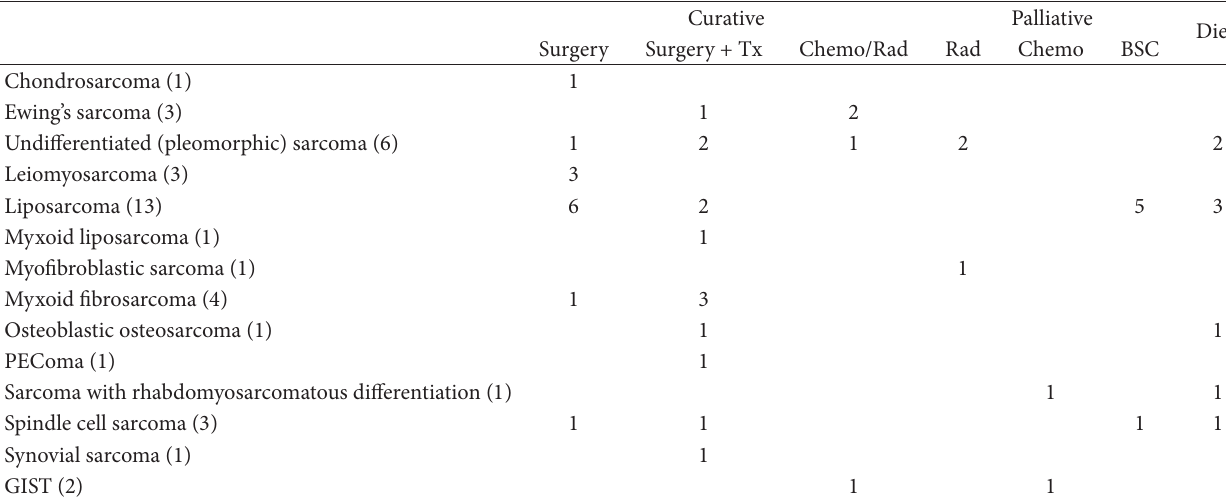
Table 5: Therapeutic approach and management of the sarcoma patients diagnosed in the 2ww